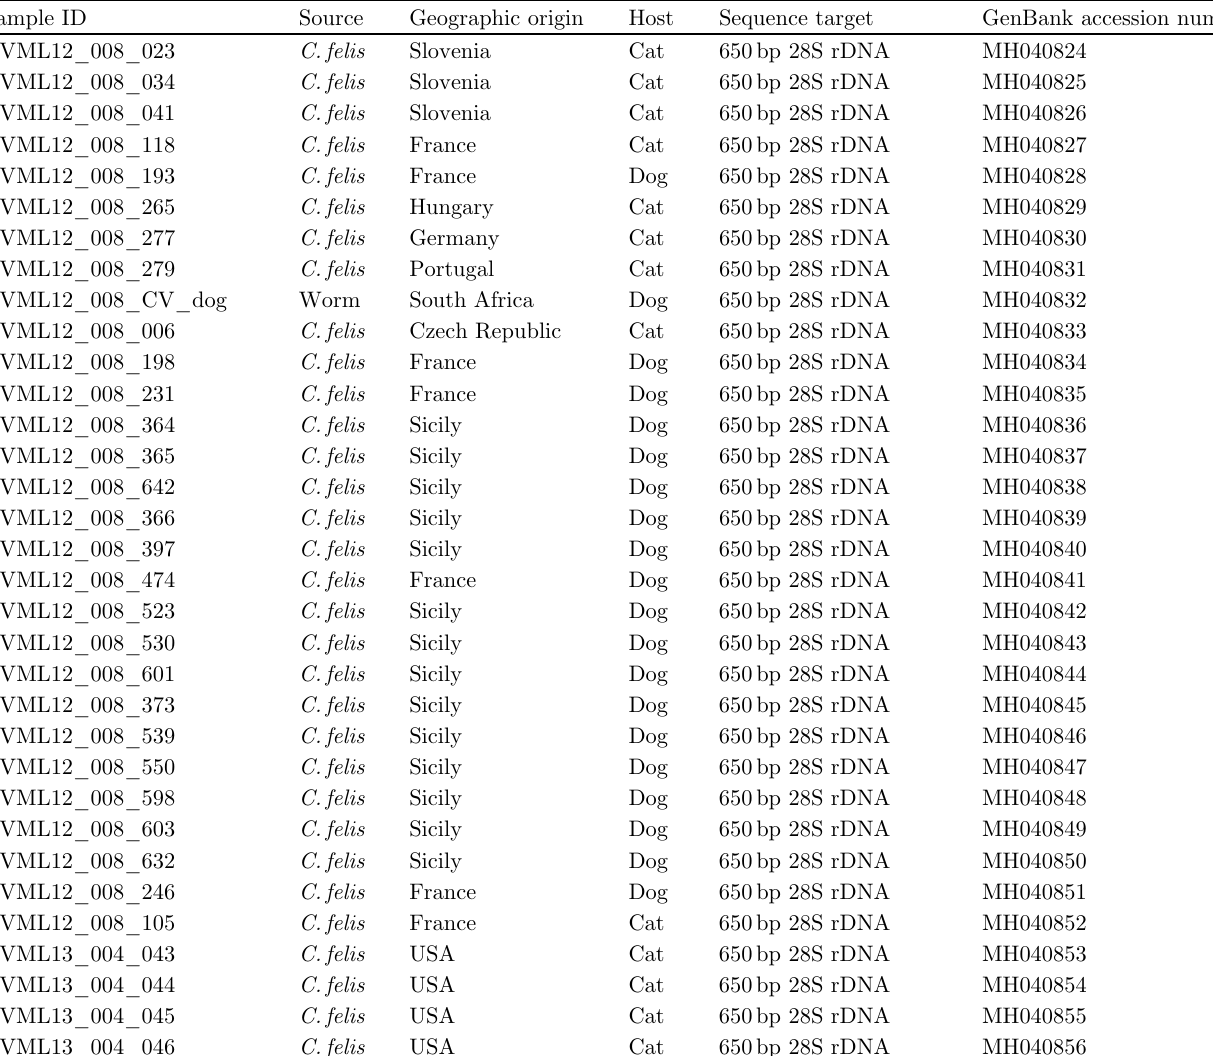
Table 5. Sample detail table providing GenBank accession